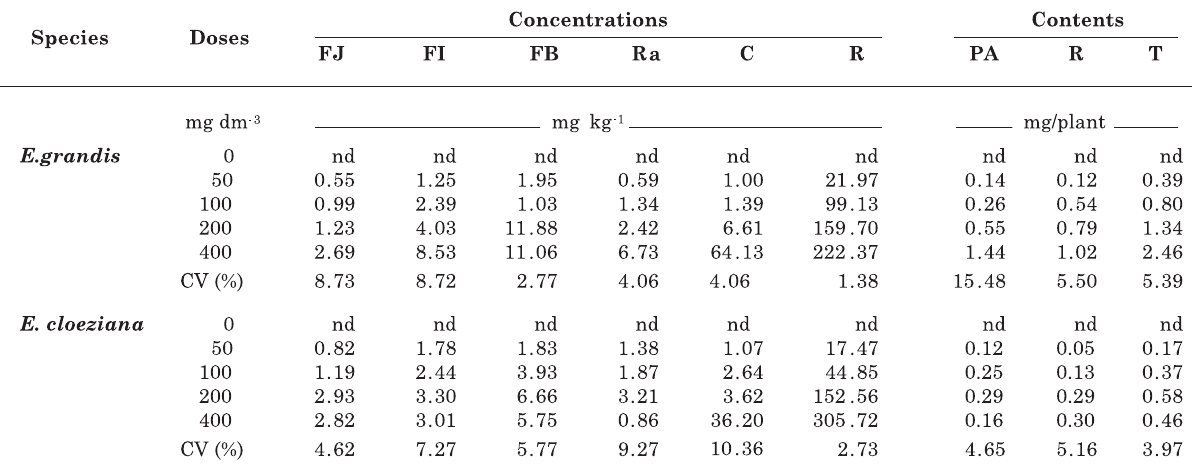
nd: concentrations below the detection limit (0.02 mg kg -1 ) by the determination method